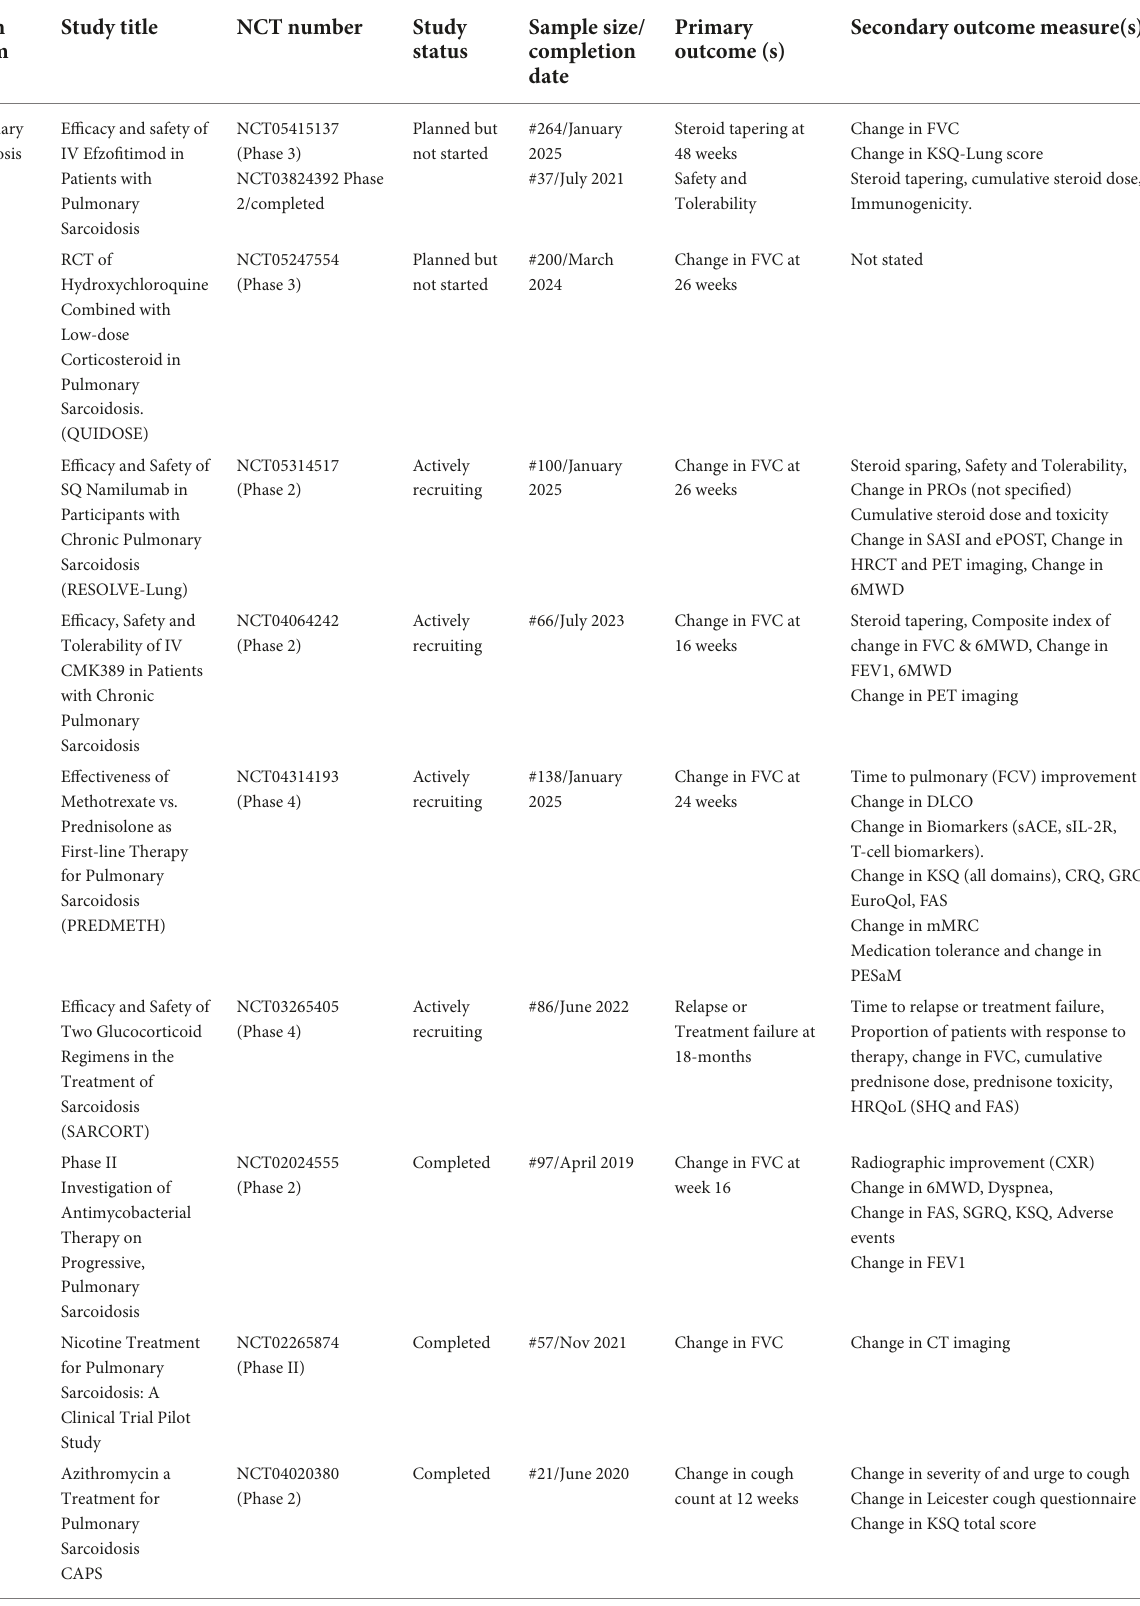
TABLE 3 Summary of ongoing, anticipated and recently completed studies in sarcoidosis from 2018 to